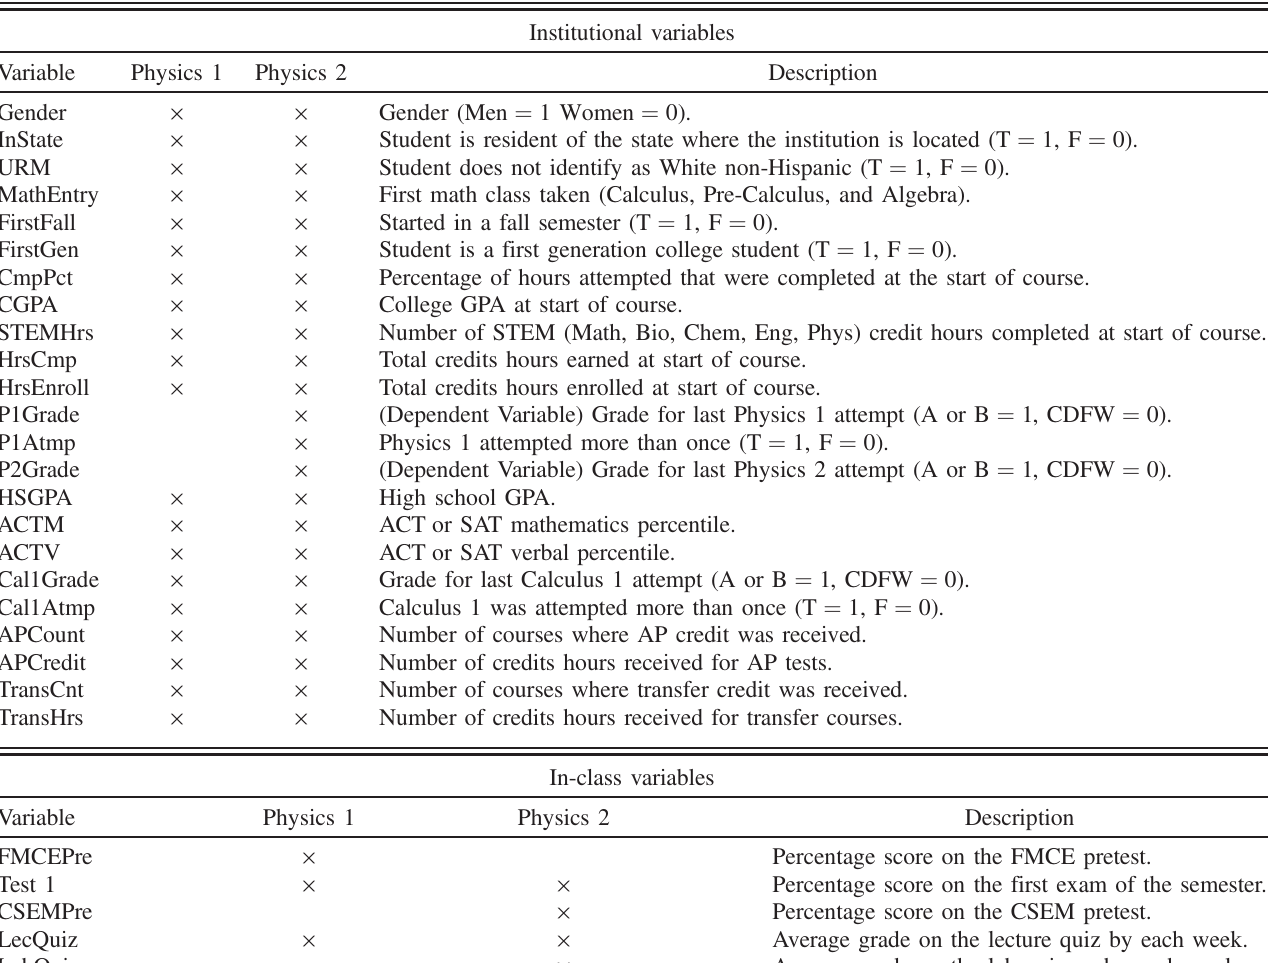
TABLE I. Full list of both institutional and in-class variables. An X in either the Physics 1 or Physics 2 columns denotes that the variable was available for that dataset. True is abbreviated T, false,